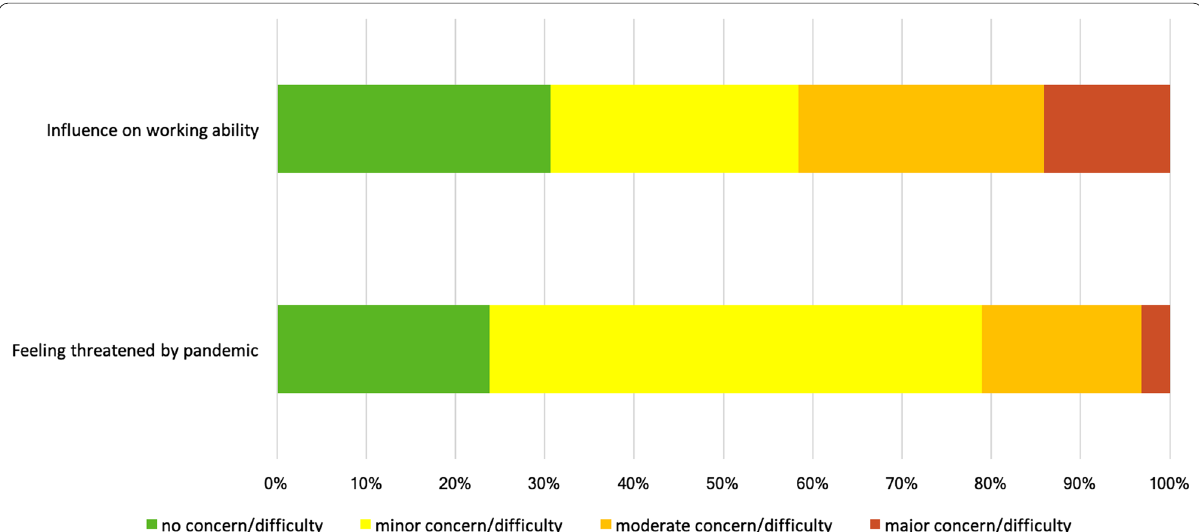
Fig. 2 Effect of the first wave of the COVID‑19 pandemic on the ability to work and feelings of being threatened by the pandemic, as reported on a 4‑point Likert scale